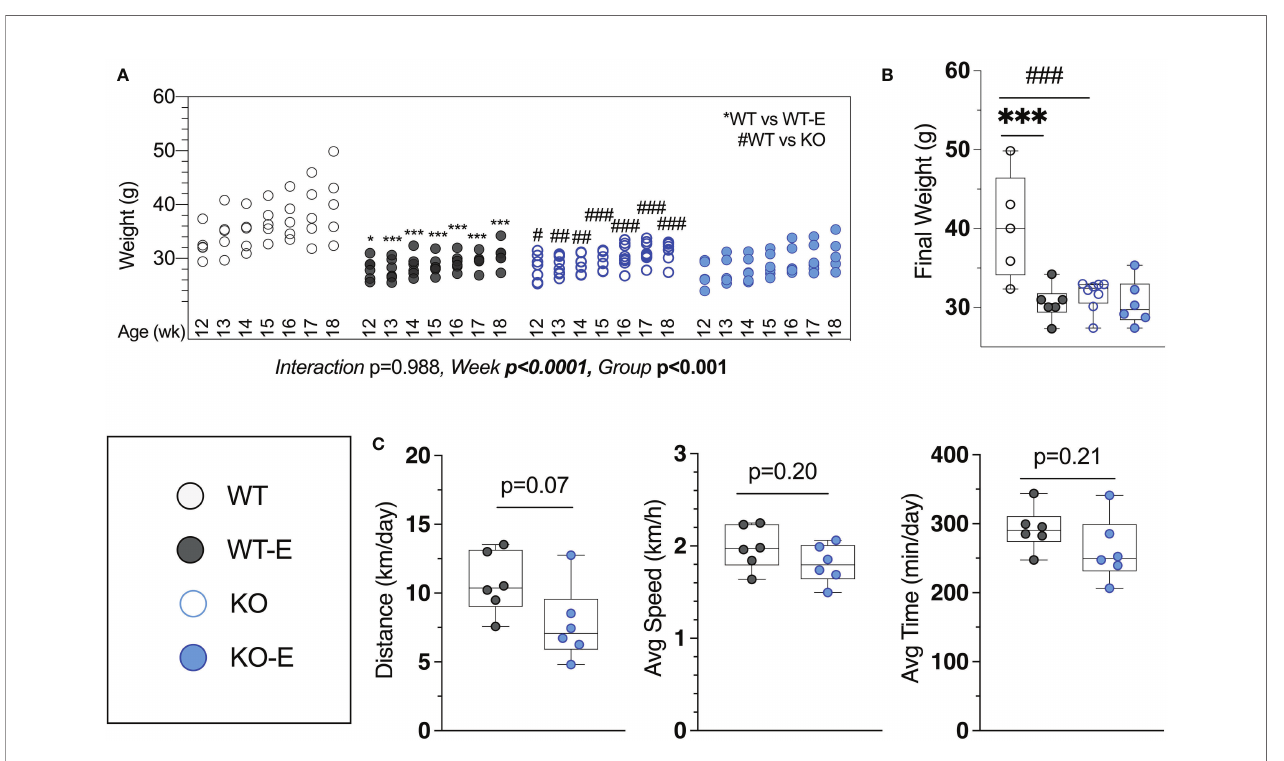
FIGURE 1 | Lipodystrohic SEIPIN KO run similar to WT despite lower body weight. Male SEIPIN KO and WT littermates allocated to voluntary running exercise (E) or non-exercise groups (KO, WT) at twelve weeks for a six-week experimental period (N=5-8). (A) Individual body weights throughout and (B) at harvest. (C) Voluntary wheel running metrics via cyclometer- average daily running distance (km/day), average running speed (km/h), and average daily running duration (min/day) in WT-E and KO-E. Data as individual values on box and whisker plots (min to max). Horizontal lines represent means. Signi fi cance via 2-way ANOVA with Tukey's post hoc (A, B) or unpaired t-test (C) Between-group * or # p < 0.05; **or ## p < 0.01; ***or ### p <